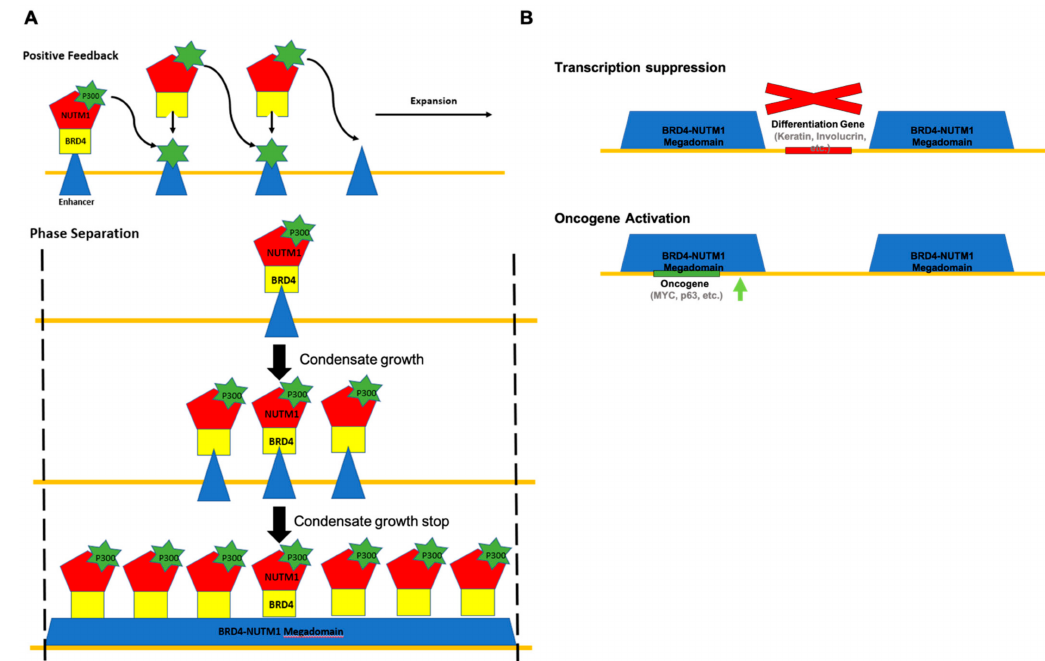
Figure 3. Models of NC initiation mechanisms. ( A ) Two possible mechanisms for the establishment of acetylated his- tone megadomains. Top: the formation of megadomains through P300-mediated positive feedback. The boundaries of megadomains are defined by currently unknown biochemical barriers. Bottom: the formation of megadomains through NUTM1-mediated phase separation and condensate growth. The boundaries of megadomains are defined by condensate size that is determined by the nuclear concentration of BET protein 4 (BRD4)-NUTM1. ( B ) Two possible mechanisms for megadomain-mediated oncogenesis. Top: megadomains drive NC formation by suppressing the expression of differentia- tion promoting genes. Bottom, megadomains drive NC formation by suppressing the expression of